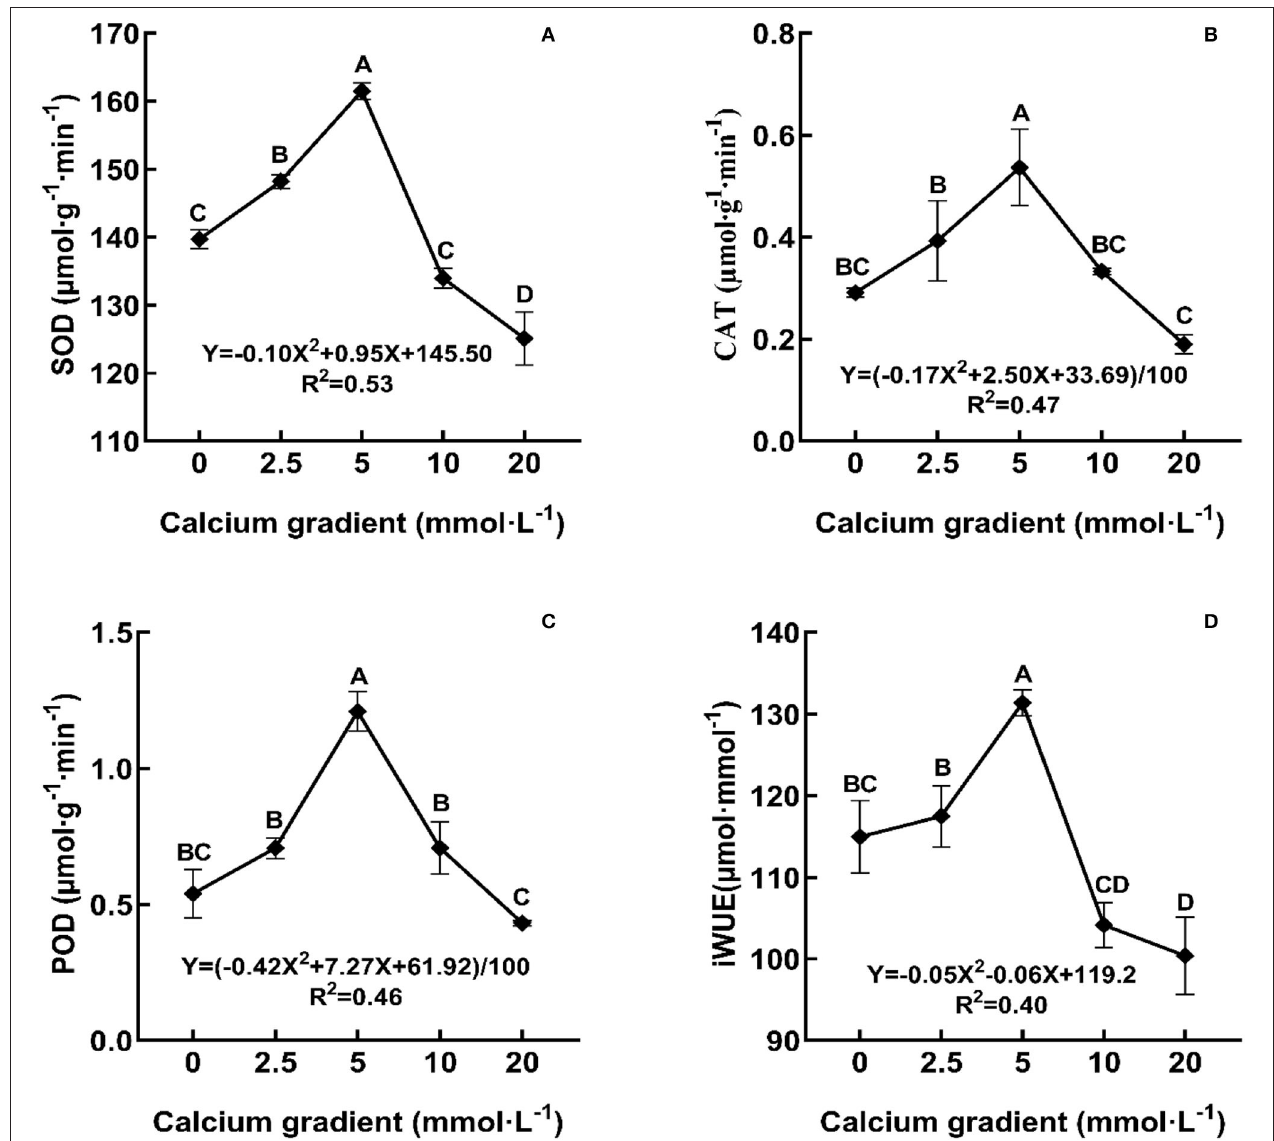
FIGURE 5 | Effect of calcium on stress tolerance of poplar seedlings. POD, peroxidase; CAT, catalase; SOD, superoxide dismutase; iWUE, long-term water use efficiency. Each column represented the mean ± SE values, n = 3; different capital letters indicate significant differences between treatments of calcium addition ( P <